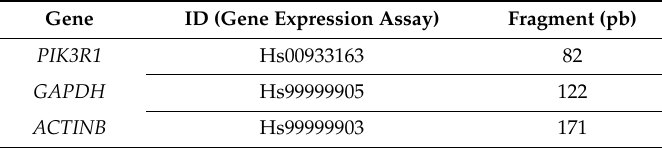
Table 4. RT-qPCR TaqMan ® Gene Expression